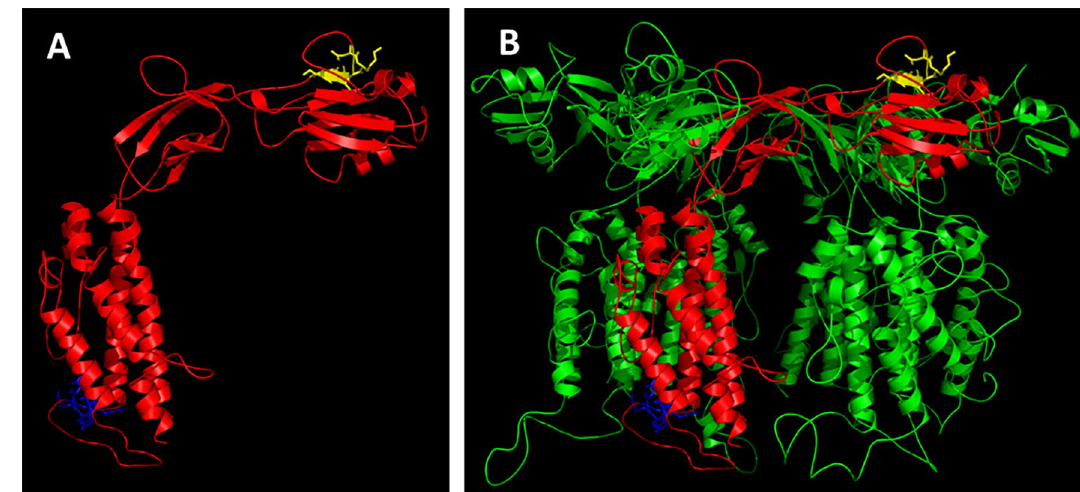
Figure 7. Modelling of C. difficile flagellar cap protein. ( A ) Secondary structure of FliD monomer. 226 NKVAS 230 epitope is indicated in yellow. 306 TTKKPKD 312 epitope is indicated in blue. ( B ) The FliD multimer that forms C. difficile flagellar